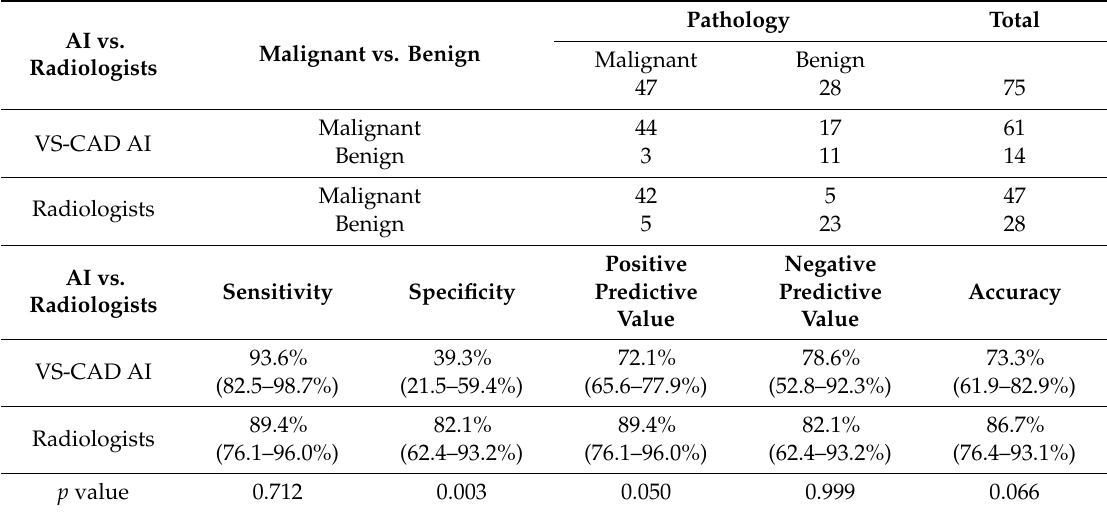
Percentages in parenthesis indicate proportions with 95% confidence